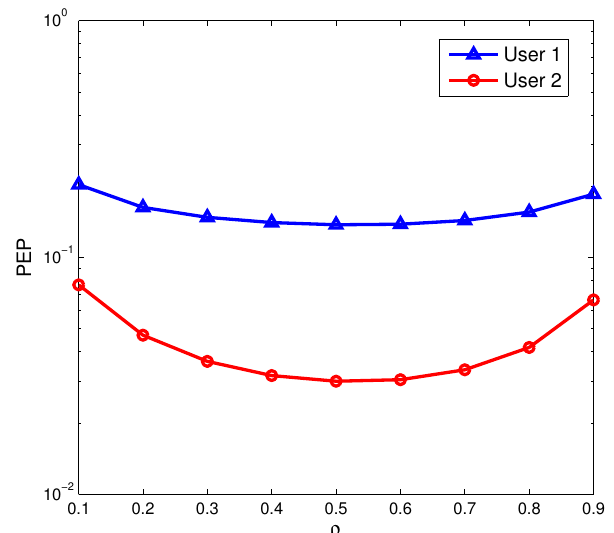
Figure 4. PEP vs. power splitter (PS) factor ρ for both